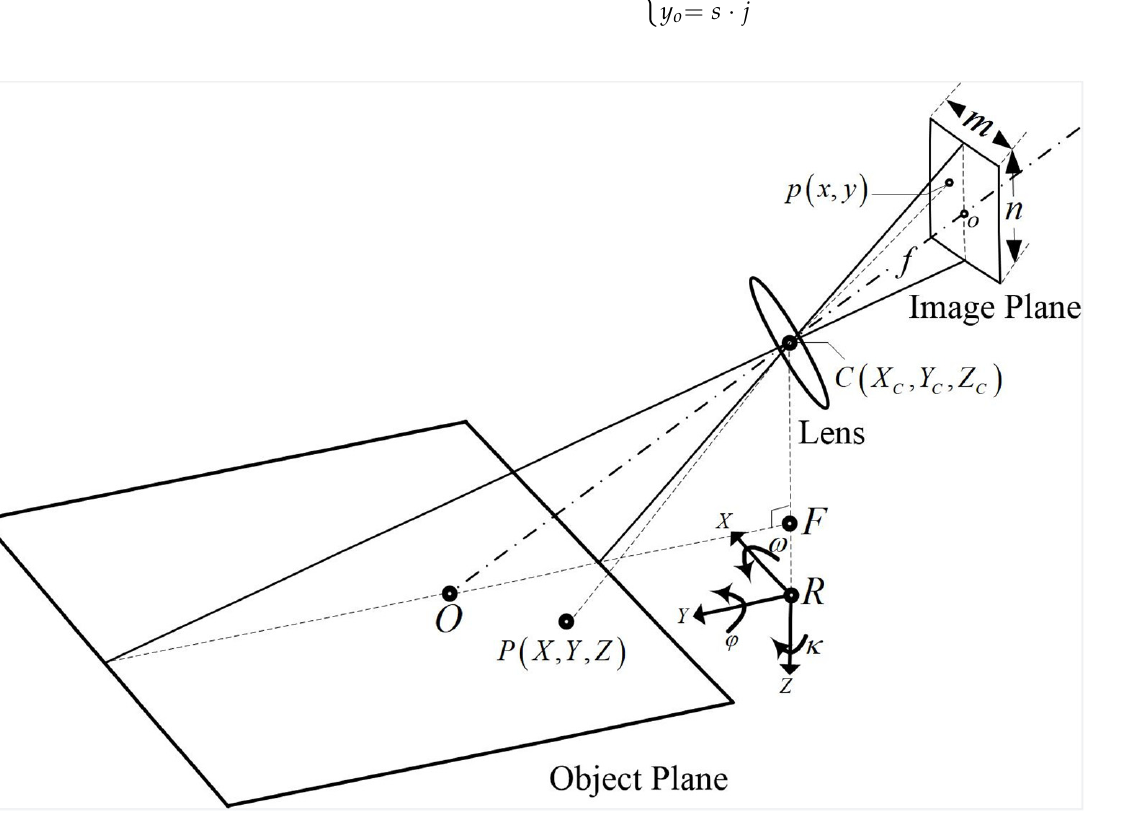
Figure 2. Model of central projection imaging under an oblique view.